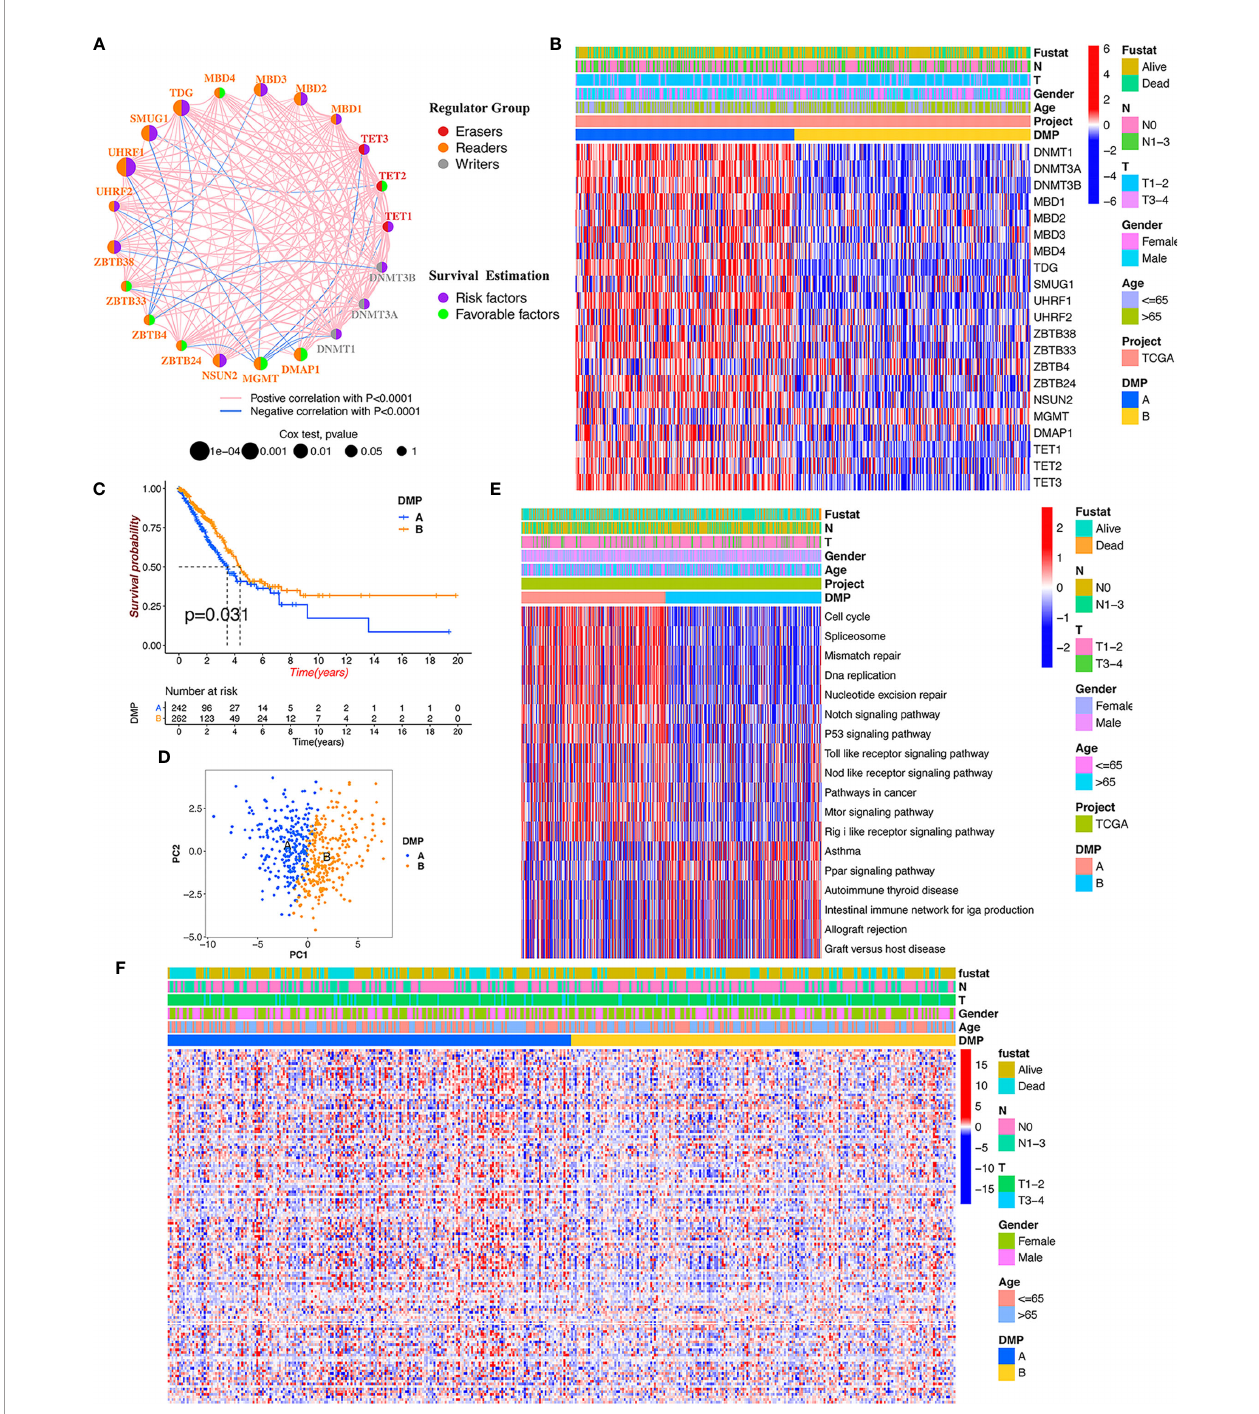
FIGURE 2 | DNA methylation modi fi cation pattern and relevant biological characterization. (A) The interaction and prognosis of 21 DNA methylation regulators in LUAD. The size of the node represents the prognostic value of each regulator; the left semicircle represents three distinct regulator types; the right semicircle represents the prognostic factors for LUAD. The line represents the correlation among regulators: red line, positive correlation; blue line, negative correlation. (B) The consensus clustering of 21 regulators in 513 TCGA-LUAD samples. Red represents higher expressed regulators. Blue represents lower expressed regulators. (C) Survival analysis of distinct DNA methylation patterns in TCGA cohort. (D) Principal component analysis for the gene expression of DNA methylation regulators to discriminate DNA methylation modi fi cation patterns. (E) GSVA enrichment analysis identifying biological pathways of each DNA methylation pattern. DMP, DNA methylation pattern. (F) The heatmap analysis of DNA methylation level evaluation in different DNA methylation